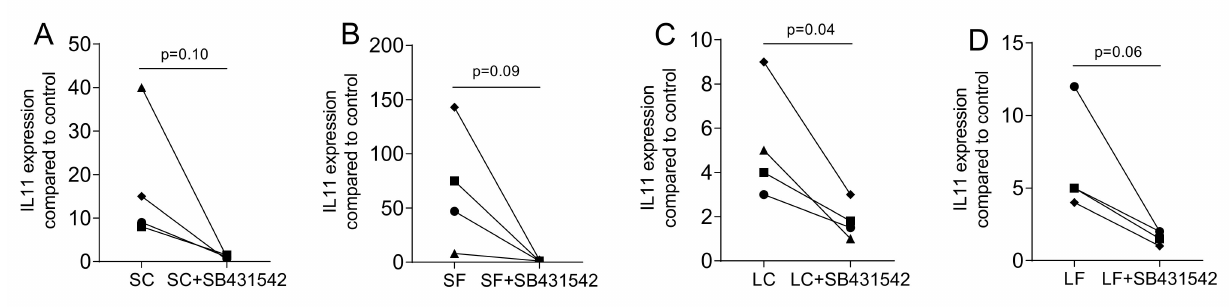
Figure 4. TGF- β receptor type I kinase with the inhibitor SB431542. Gingival fibroblasts were exposed to aqueous supernatants of ( A ) OraGRAFT ® Demineralized Cortical Particulate (SC) and ( B ) OraGRAFT ® Prime (SF) and ( C , D ) the acid lysates of the two respective allografts (LC and LF). The expression of IL11 was diminished by SB431542, the TGF- β receptor type I kinase. N = 4. Statistic is a paired t -test.